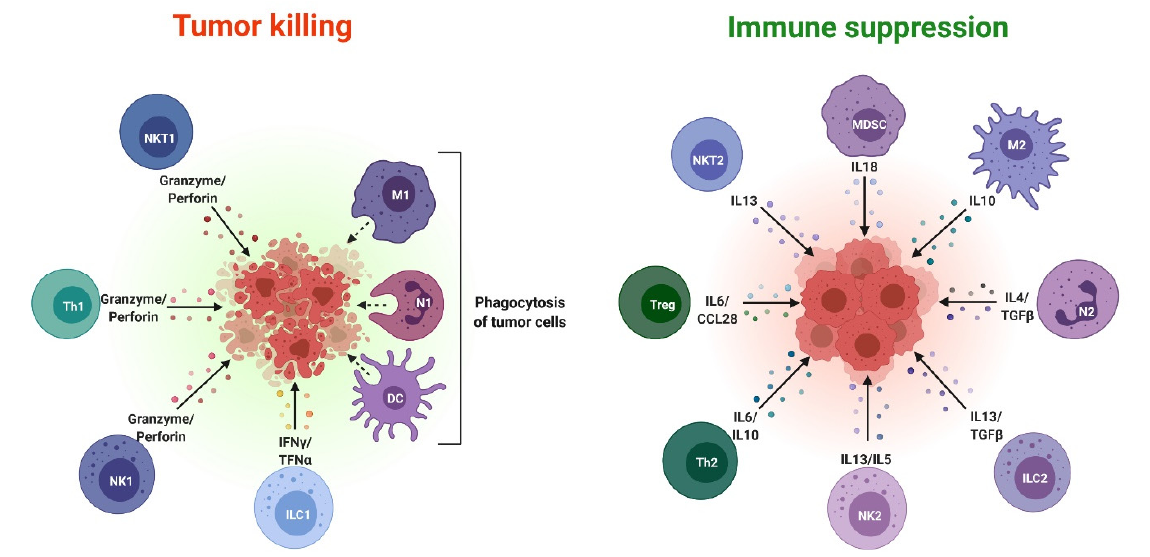
Figure 3. Pro and antitumor immune cells in the tumor microenvironment. Pro and antitumor effects of immune cell subsets in the tumor microenvironment, including common mediating cytokines. Proinflammatory macrophages (M1); neuro-1 (N1); dendritic cells; group 1 innate lymphoid cells (ILC1); natural killer 1 (NK1); type 1 T helper (Th1); type 1 natural killer T (NKT1). This image was created using BioRender (http://biorender.com/ accessed on 10 August 2021).